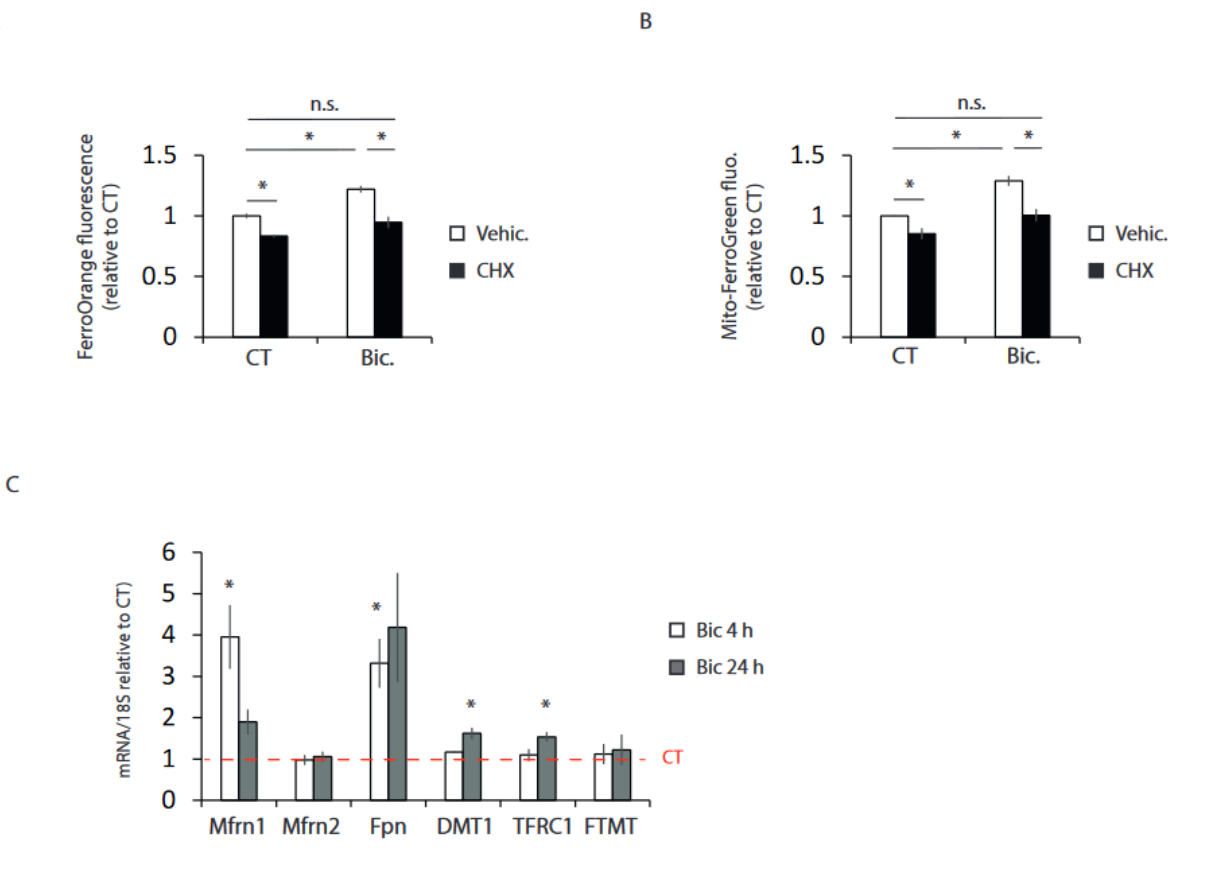
Figure 3. Synaptic activity induces the transcriptional expression of iron metabolism genes. ( A ) Cytoplasmic and ( B ) mitochondrial ferrous content was analyzed in control and 24 h stimulated neurons in absence or presence of the translation inhibitor cycloheximide (10 µ M) as indicated (n = 3 and 4 independent experiments, respectively). ( C ) Neurons were stimulated for 4 or 24 h, and mRNA expression of the indicated genes was determined by qPCR (n = 4–8 independent experiments). The red dashed line indicates mRNA levels in resting neurons * p < 0.05, one-way ANOVA, followed by Tukey’s post hoc test except for Fpn and FTMT qPCR results, which used Kruskal–Wallis, followed by Dunn’s post hoc test. n.s. = non-significant.